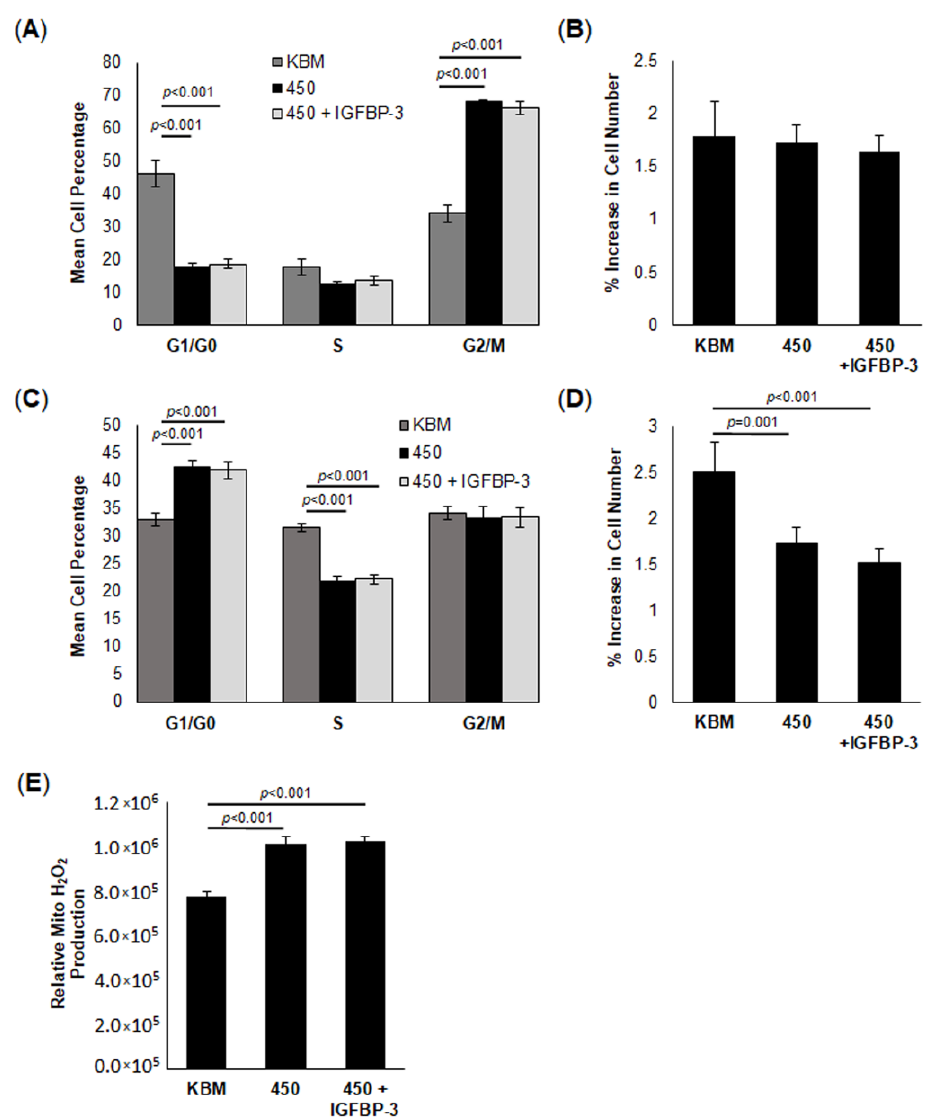
inhibitory protein.